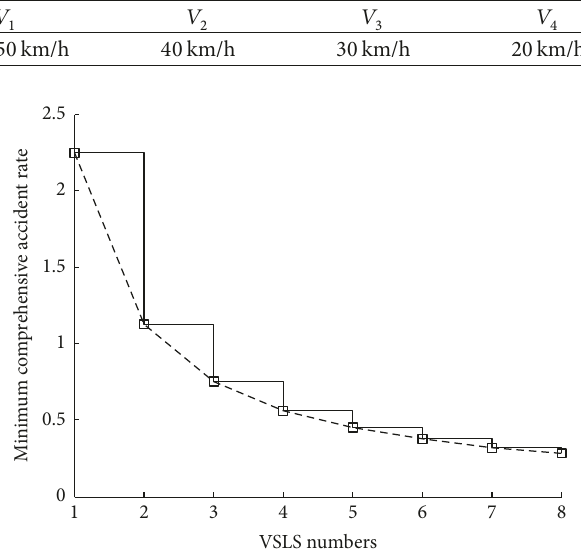
Figure6:Reductiontrendoftheminimumcomprehensiveaccident rate.